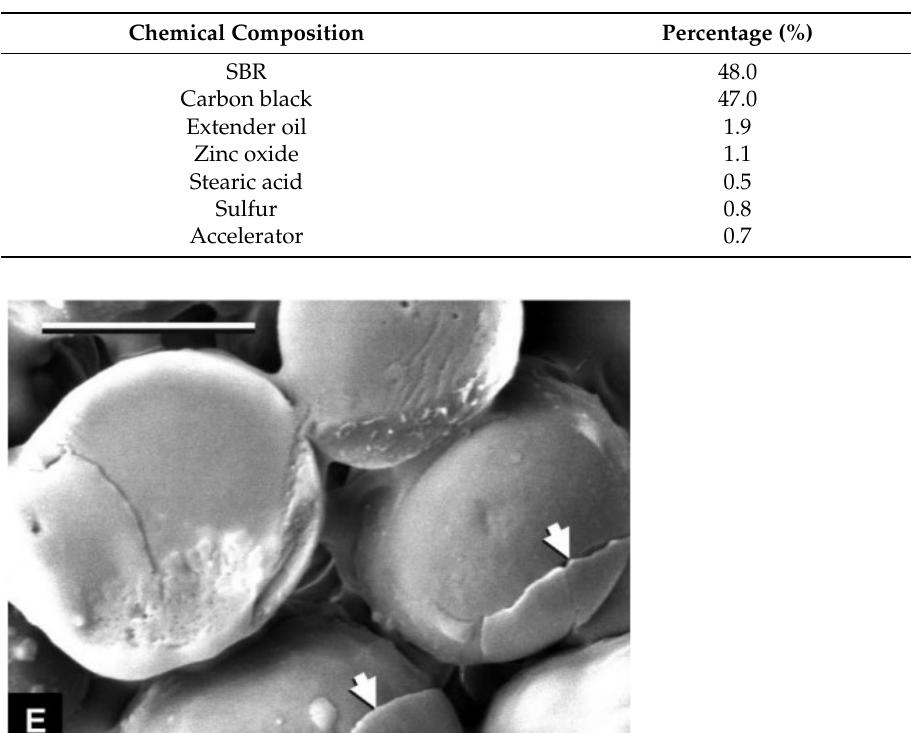
Table 4. Rubber chemical composition [53].